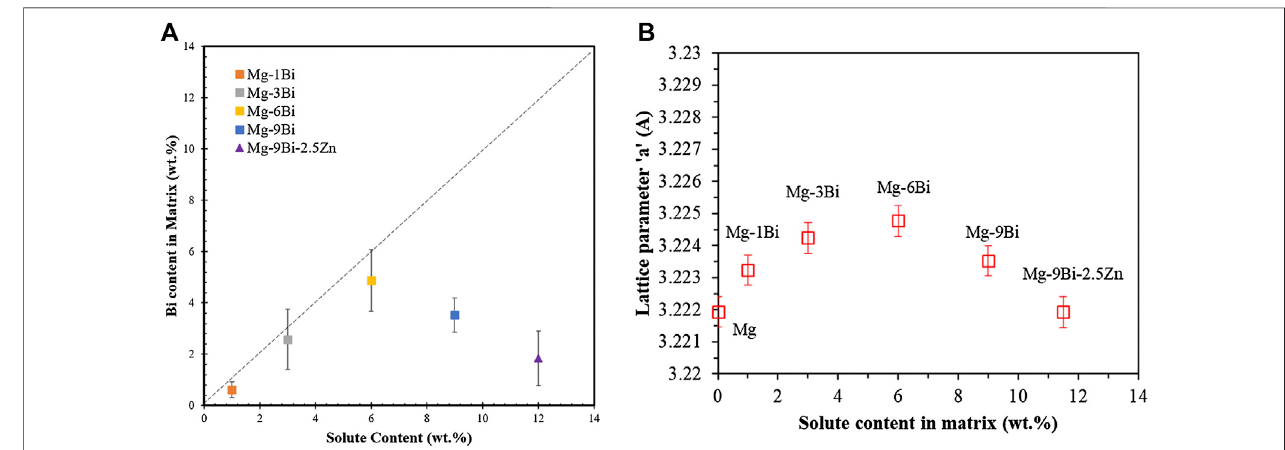
FIGURE 13 | (A) Bi concentration in matrix measured by EDX vs. Bi concentration obtained by ICP. The dashed line shows the idea case that Bi is dissolved thoroughly in the matrix. (B) Lattice parameter “ aa ” variation of Mg as a function of solute concentration in the matrix.